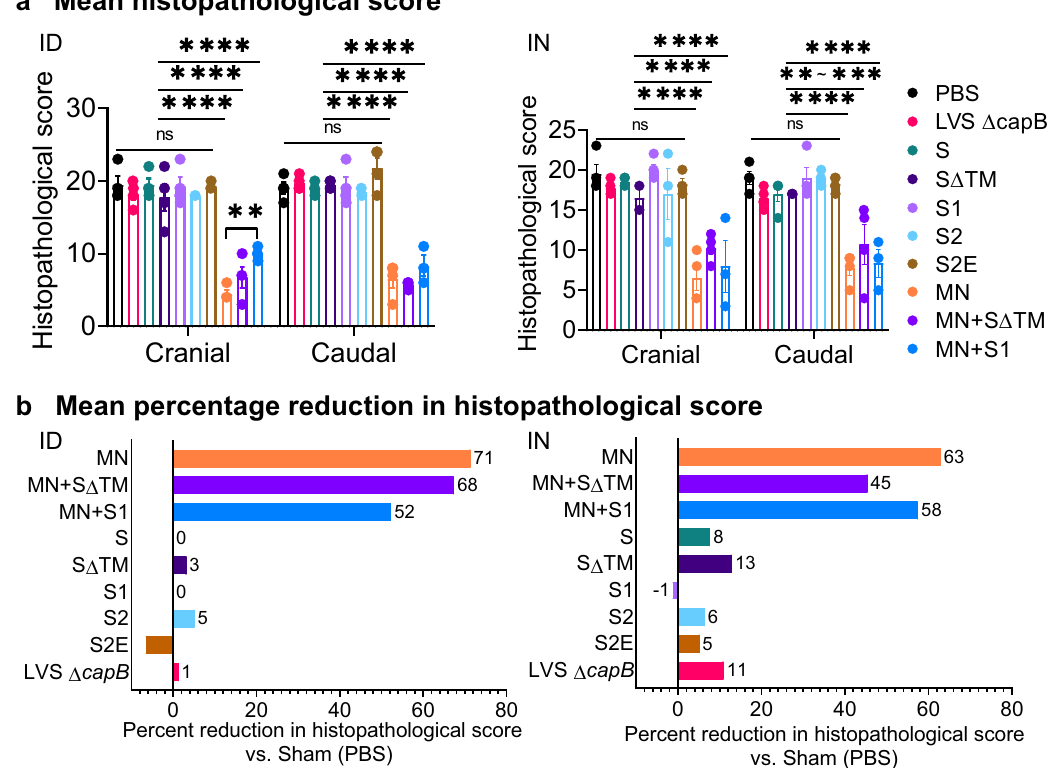
Fig. 3 Lung histopathology on Day 7 after SARS-CoV-2 IN challenge. Hamsters ( n = 4, equal sex) were immunized ID or IN as described in Fig. 2 and euthanized at 7 days post challenge for histopathologic examination of their lungs. a Cranial and caudal lung histopathology post challenge in hamsters immunized ID (left) or IN (right) were separately scored on a 0 – 5 or 0 – 4 scale for overall lesion extent, bronchitis, alveolitis, pneumocyte hyperplasia, vasculitis, and interstitial in fl ammation; the sum of the scores for each lung are shown (mean ± SE). The histopathological score evaluation was performed by a single pathologist blinded to the identity of the groups. Each symbol represents one animal. Data are mean ± SE. ** P < 0.01; *** P < 0.001; **** P < 0.0001 by two-way ANOVA with Tukey ’ s multiple comparisons (GraphPad Prism 8.4.3); ns, not signi fi cant. b The mean percentage reduction in the combined cranial and caudal lung histopathology score compared with Sham (PBS)-immunized animals was calculated for each